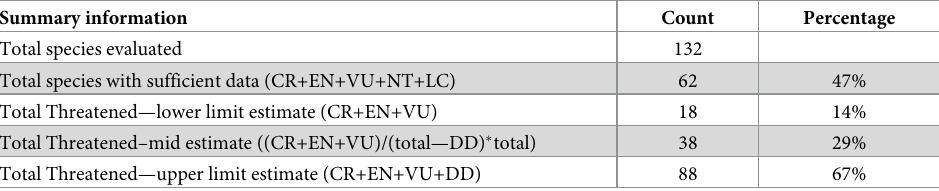
Table 1. IUCN Red List summary information for 132 North American firefly